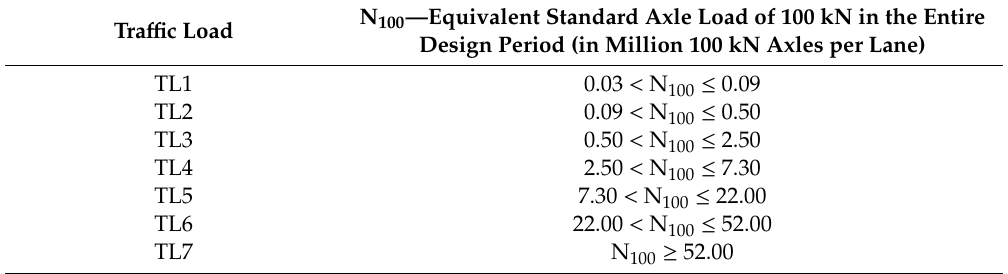
Table 3. Tra ffi c categories.